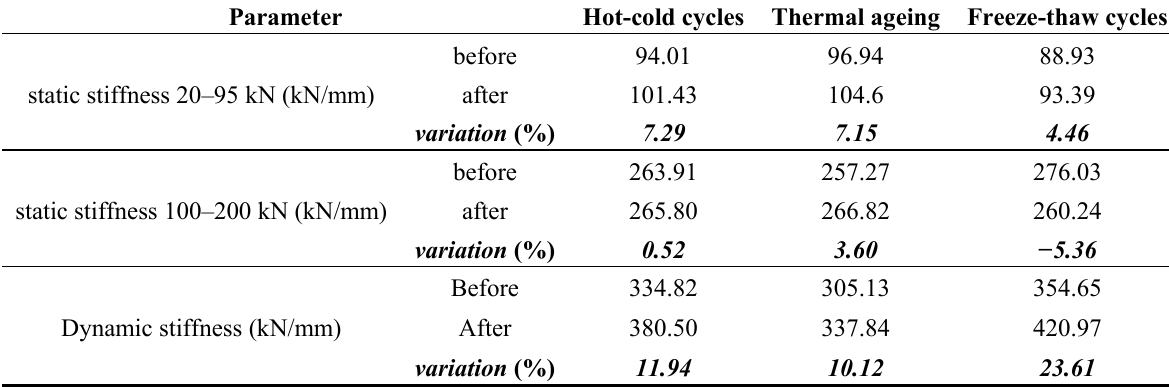
Table 4. Change in tire pads mechanical properties due to climatic actions. Bold italics show the variation between the properties before and after applying climatic